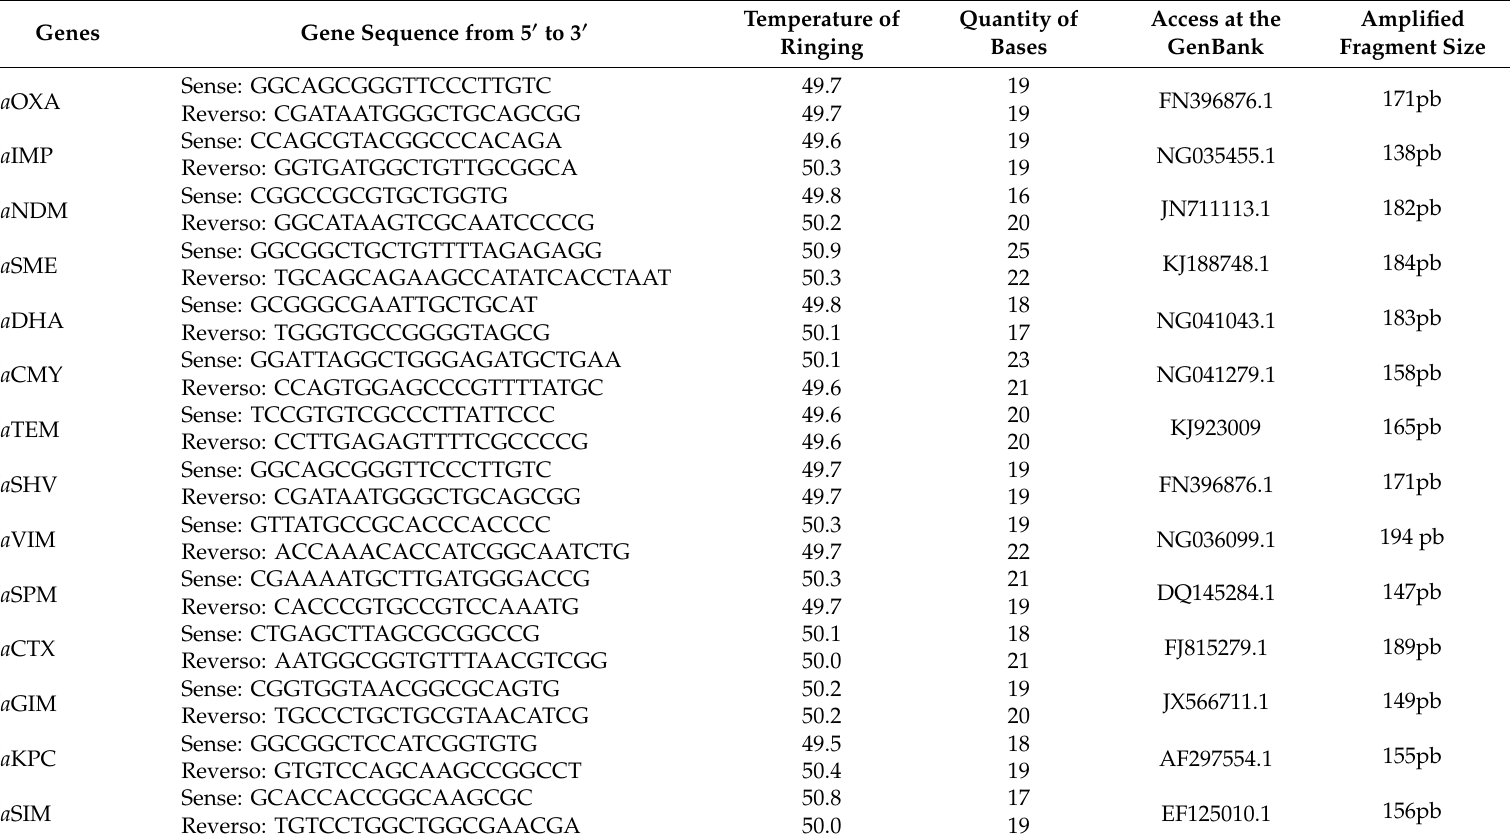
Table 5. Oligonucleotides used for amplification of the β -lactam resistance genes of this study.